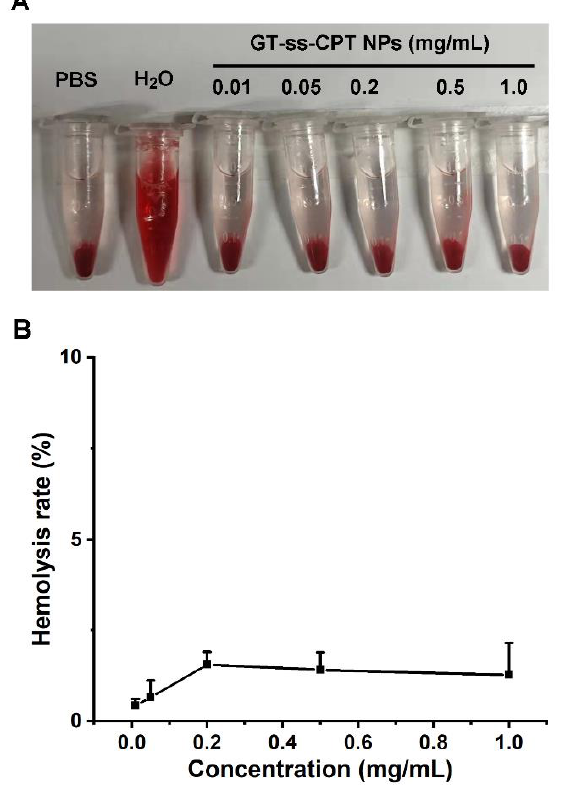
Figure 5. ( A ) Image showing the mice BRCs after incubation with various concentrations of GT-ss- CPT NPs. ( B ) Hemolysis rate of mice BRCs after incubation with various concentrations of GT-ss-CPT NPs ( n = 3).